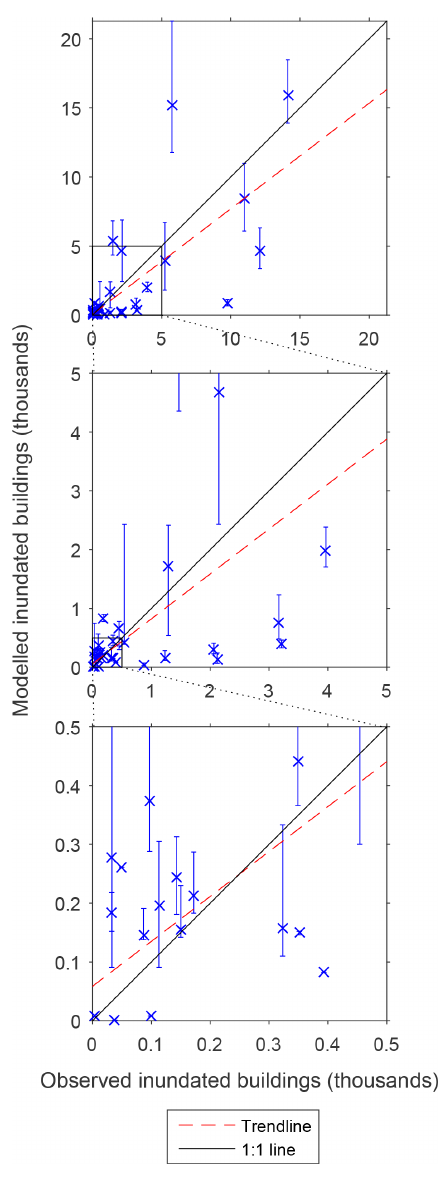
Figure 6. Scatter plots illustrating the observed (NFIP and IA) versus the modelled count of inundated buildings for each of the 35 events. Blue crosses represent the simulated count in the 1.0*Q model, with error bars representing the range of counts between the 0.8*Q and 1.2*Q simulations. The trend line represents a linear polynomial fitted to the optimum of each event’s three simulations. Descending panels are sequentially more magnified towards the ori-